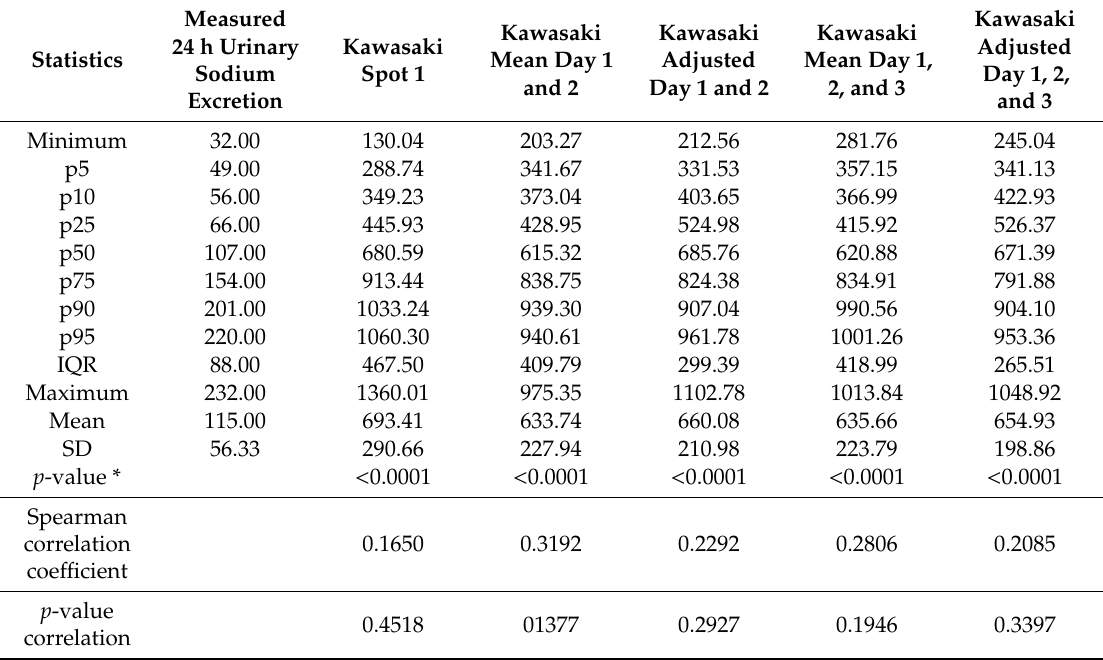
Table 6. Prediction equations to estimate 24 h Na using correction applied for both spot Na and spot Cr using the Kawasaki equation (mmoL /